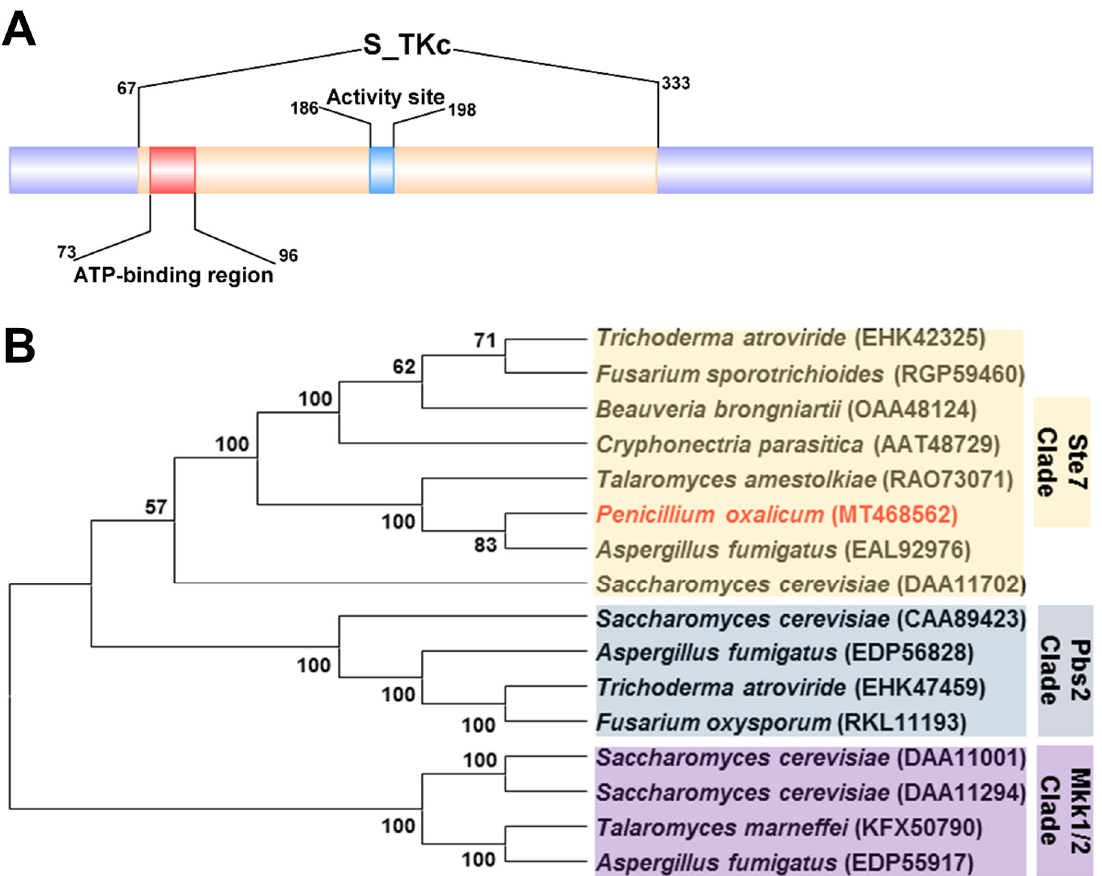
Figure 1. Structure and phylogenetic analyses of protein kinase PoxMKK1 (POX07948). ( A ) Con- served domain. S_TKc, serine/threonine protein kinase catalytic domain. ( B ) Phylogenetic tree of PoxMKK1 and its homologs. The phylogenetic tree was generated by the MEGA X software using the neighbor-joining (N–J) method. The numbers at the branch nodes are bootstrap values (>50%) based on 1000 replicates.